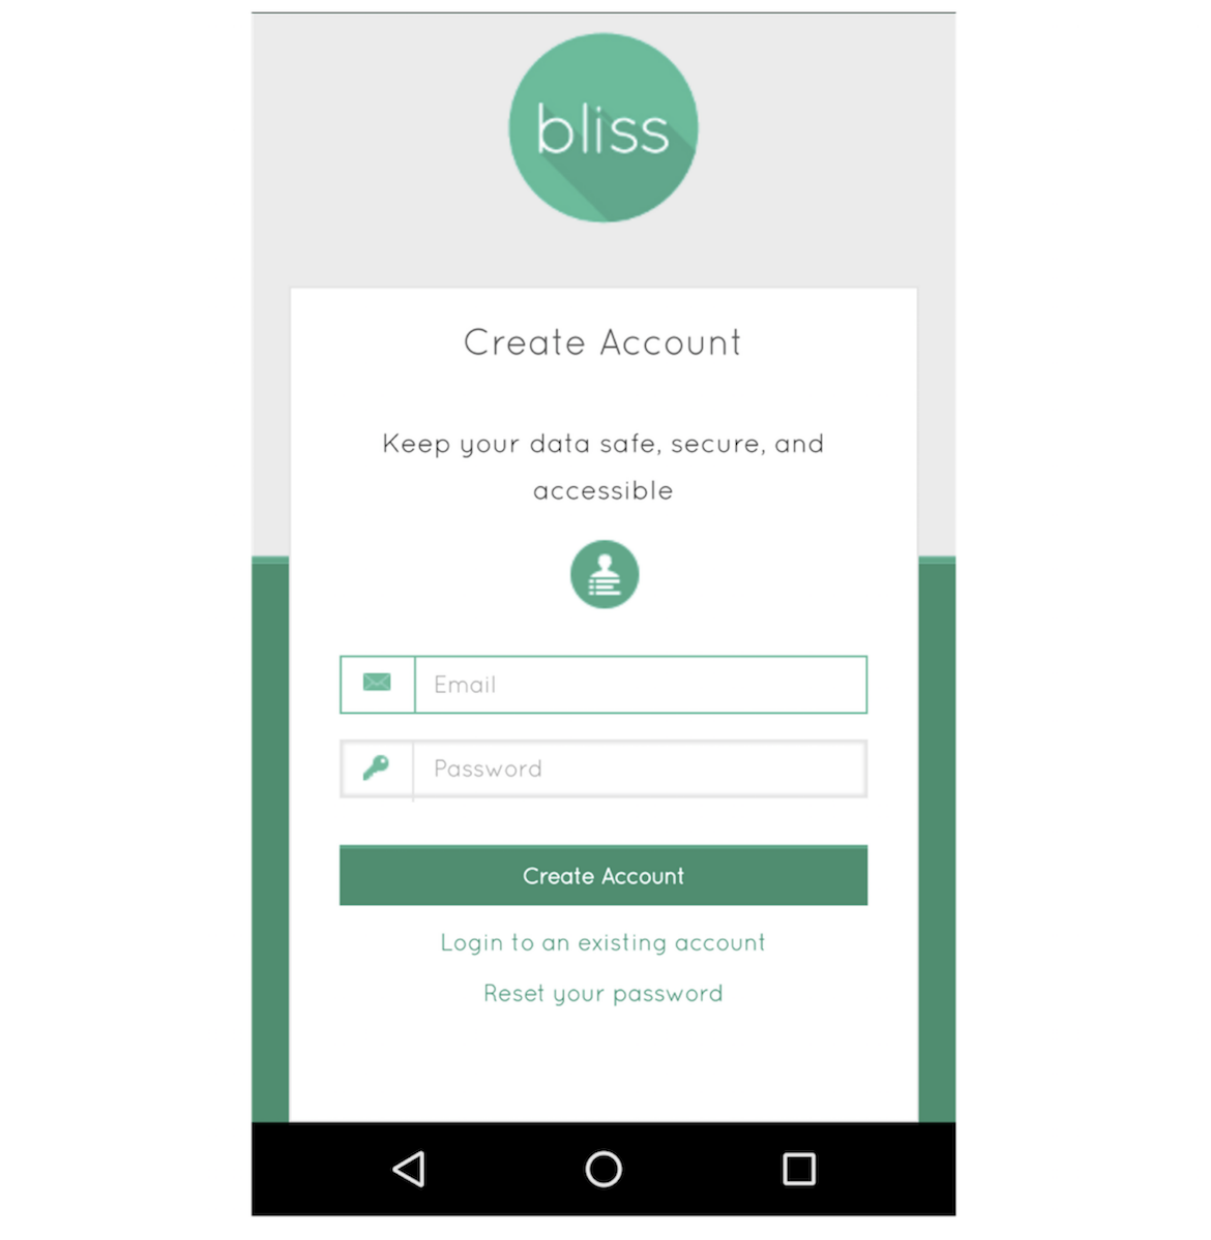
Figure 2. Screenshot of initial login screen of the Bliss